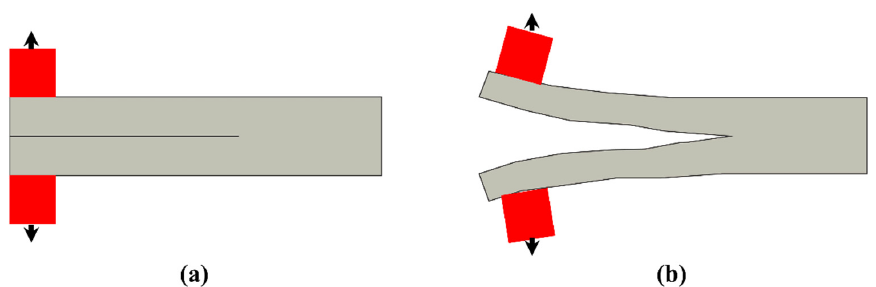
Figure 16. Schematic representation of the cohesive law [89].